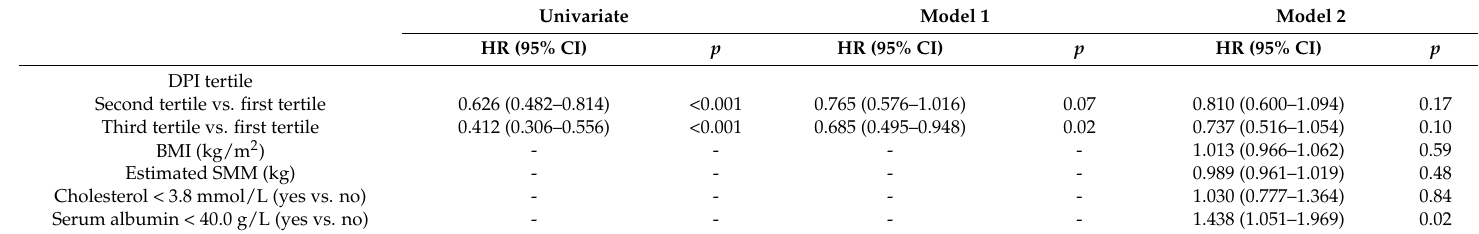
Table 2. Effect of DPI on renal survival.